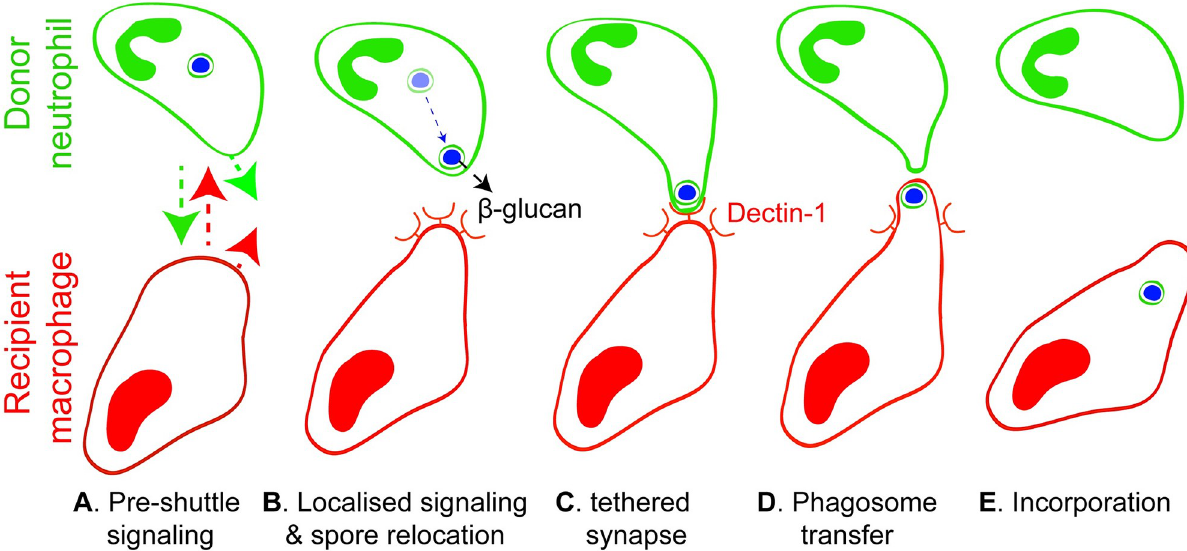
Fig 9. Model of neutrophil-to-macrophage conidial shuttles. The schematic indicates 5 steps in neutrophil-to-macrophage conidial shuttling that accommodate morphological and mechanistic insights from these studies. Undefined signals slow the donor neutrophil and recipient macrophage and bring them into proximity (A), leading to β -glucan–dependent intercellular shuttling signals and spore relocation within the donor cell towards the recipient macrophage (B). An intercellular synapse forms with tethering (C), leading to phagosome transfer (D) and its incorporation into recipient macrophages by a mechanism partially dependent on Dectin-1, at least initially retaining components of the membrane-lined donor cell phagosome (E). Both donor and recipient cells remain active following shuttling, and eventually, both depart